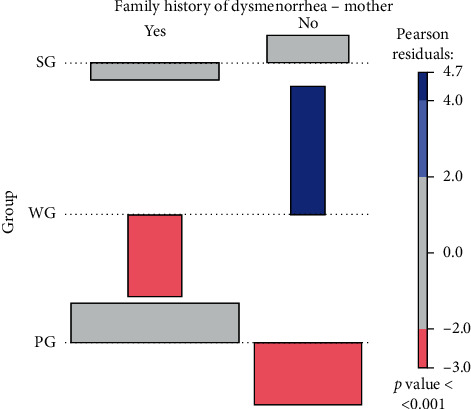
A diagram of multidimensional data association for respondents from the groups (PG, SG, and WG) and the occurrence of dysmenorrhea in the respondents' mothers (answers: yes, no). A significant statistical relationship p < 0.001 was found between the multidimensional data. PG, women with dysmenorrhea during every cycle, SG, women with dysmenorrhea occasionally, and WG, women without dysmenorrhea.